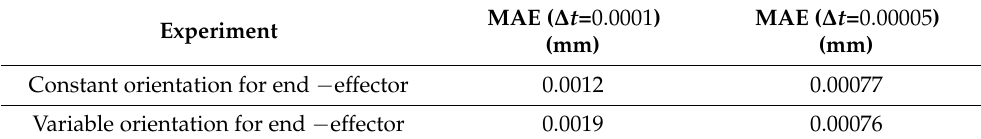
Table 2. Variation of MAE.